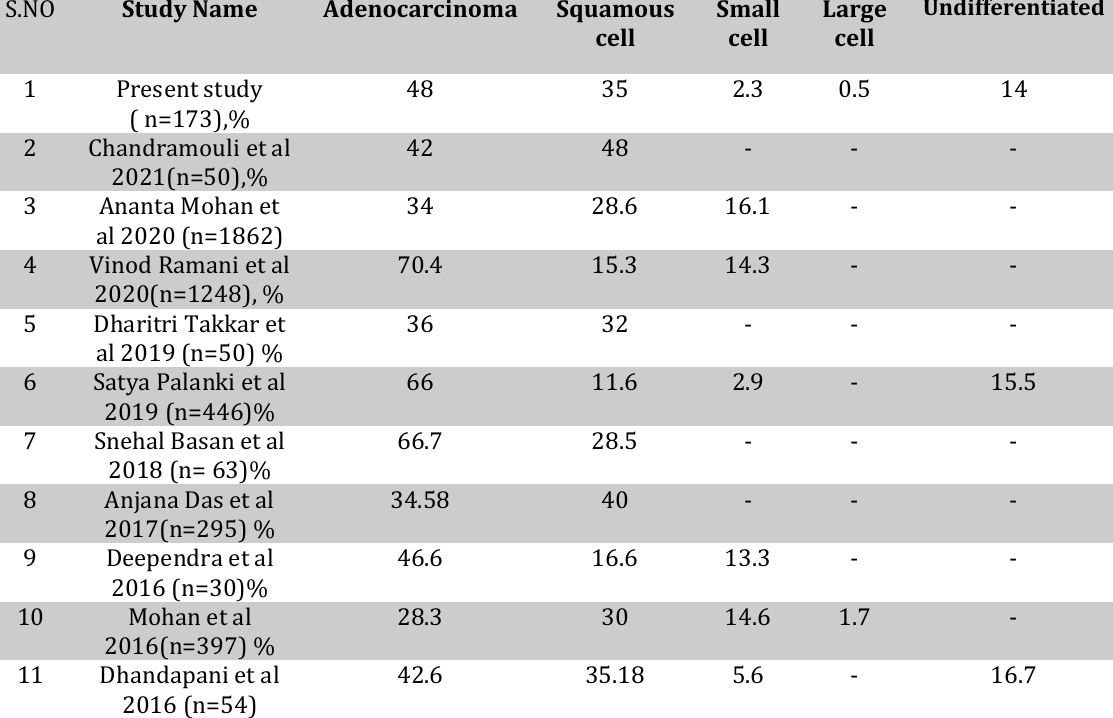
Table 4. Histolopathological type of various malignancies and comparisons with other